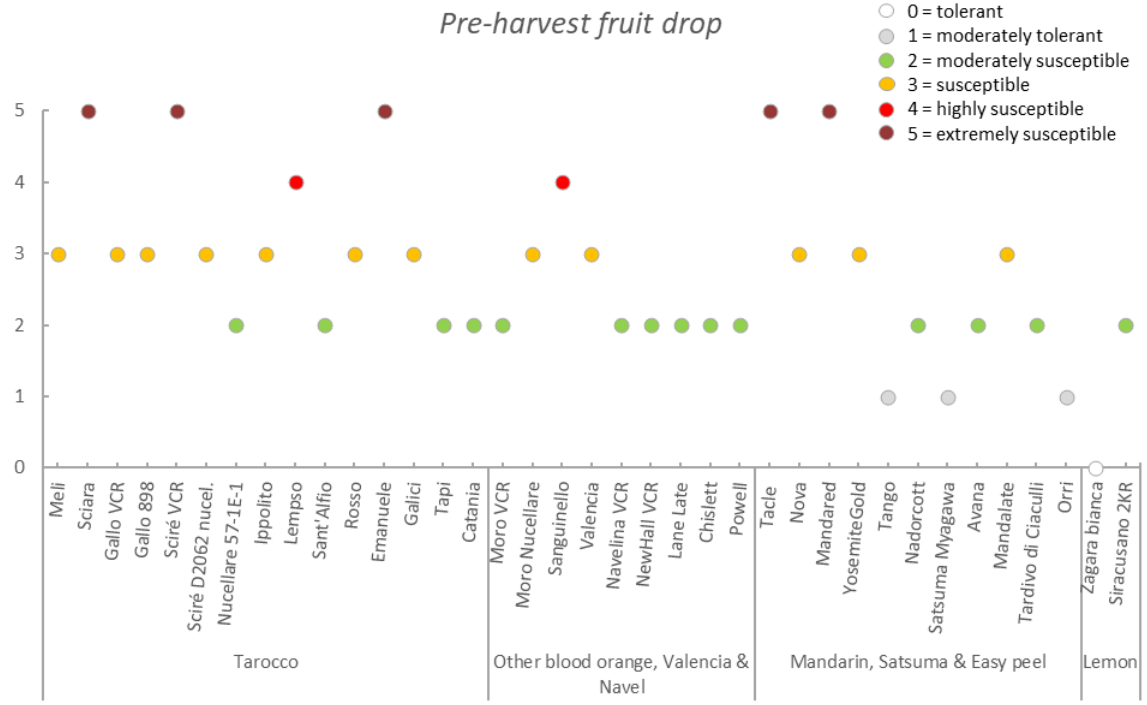
Figure 12. Maximum potential infection risk of pre-harvest fruit drop recorded on detected Citrus germplasm. Data obtained from several Sicilian citrus production areas (from 1-to-20) within Citrus groups surveyed for three periods intercepting an eleven-year survey.